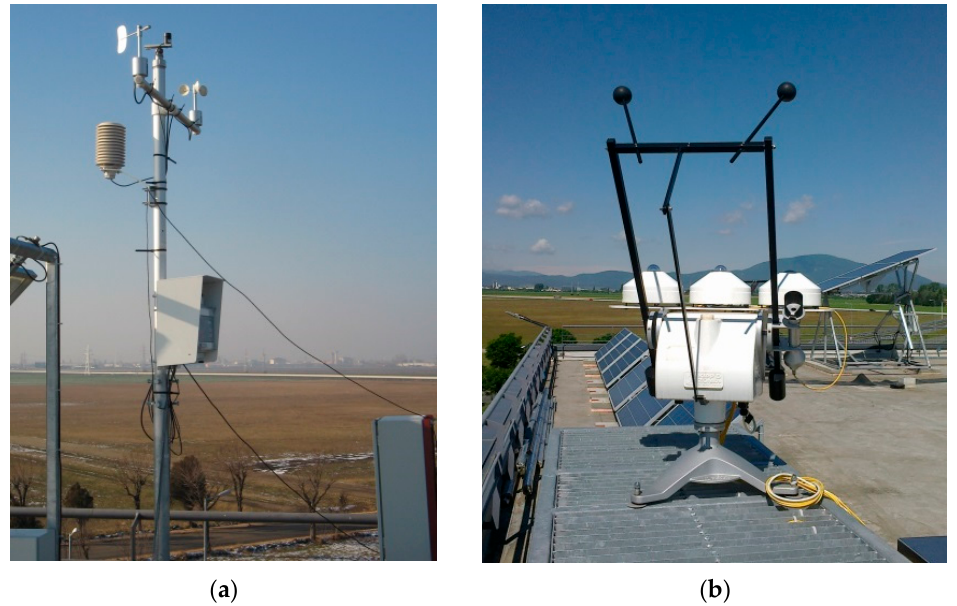
Figure 6. Delta-T weather station ( a ) and Solys 2 sun tracker ( b ) installed in the RESREC of the Transilvania University of Brasov, Romania.